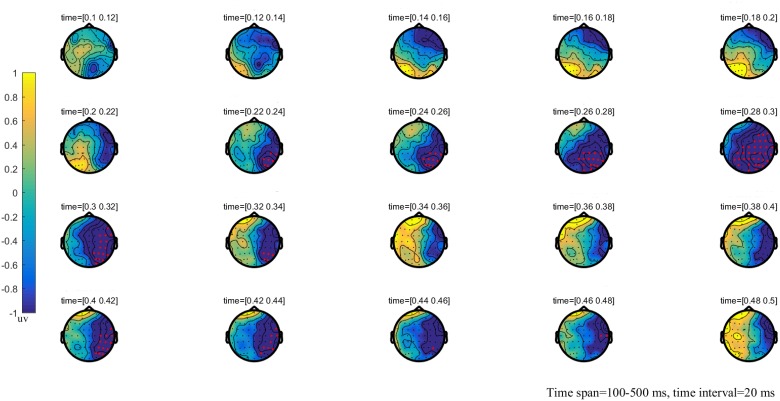
The global brain topographic map of the difference between NT and MT, time from 100 to 500 ms after stimulation onset. The results show that the difference of waveform between the two stimuli is mainly reflected in the right posterior brain area of 260–330 ms. Red points indicate that these electrodes are members of significant clusters.